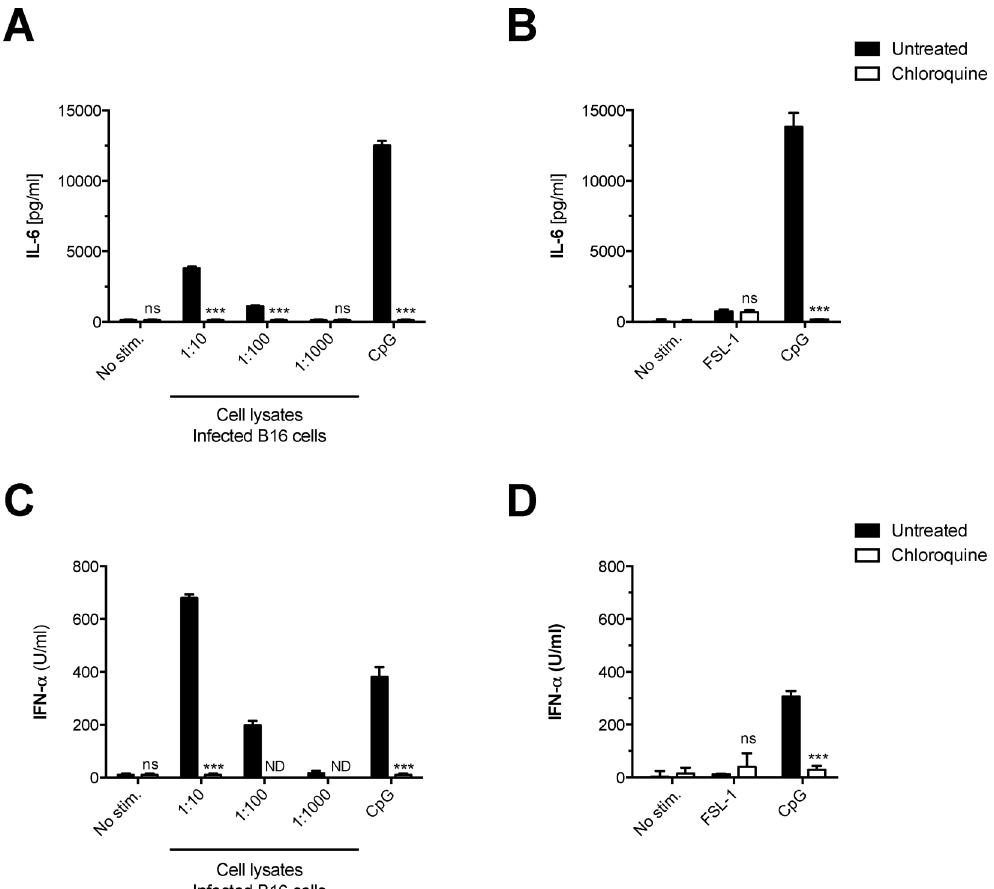
Fig 4. Plasmacytoid dendritic cells produce IFN- α and IL-6 in response to Mycoplasma hyorhinis -infected B16 cells. Bone marrow-derived plasmacytoid DCs were cultured in the presence of decreasing concentrations of lysates derived from Mycoplasma hyorhinis -infected B16 cells (A, C) or different TLR stimuli (B, D) . In some conditions, chloroquine was added to the pDC cultures. After 18 h, IL-6 and IFN- α levels in the pDC culture supernatant were analyzed by ELISA. Data give the mean + S.E.M. of triplicate samples and are representative of at least two independent experiments. Asterisks indicate statistically significant differences to the appropriate wild-type or untreated